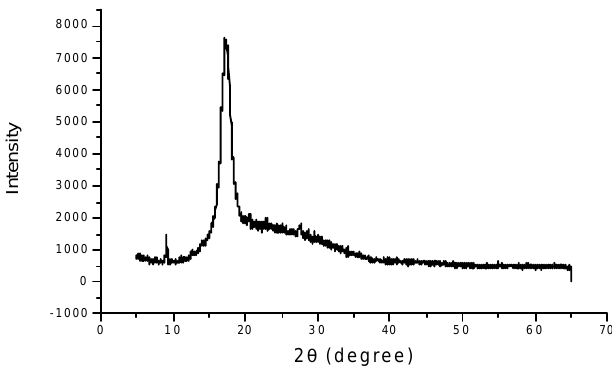
Figure 4. The XRD spectra of an aerosol